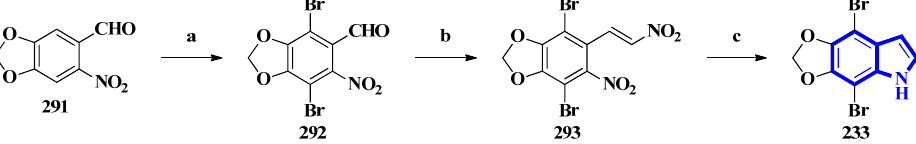
Figure 19. Amakusamine derivatives synthesized 294–308 . The first total synthesis of griseofamine B ( 314 ) and its three stereoisomers, 16-epi- griseofamine B, ent-griseofamine B, and 11-epi-griseofamine B ( 317 , 321 , and 323 ), was carried out in 2022. Compound 314 is an indole-tetramic acid alkaloid isolated from the Penicillium griseofulvum fungus in 2018 [86]. In the total synthesis, 4-bromo tryptophan methyl ester hydrochloride was used as the starting reagent, with its l-enantiomer being used to synthesize compounds 314 and 317 . d-Enantiomer 4-bromo tryptophan methyl ester hydrochloride was used to synthesize compounds 321 and 323 . All four compounds were obtained in five steps with yields of 18%, 5%, 19%, and 5%, respectively (Figure 20) [87]. Next, compound 309 was reacted with Boc 2 O, Et 3 N, and DMAP under reflux condi- tions in DCM to afford 310 in 90% yield. A Heck–Mizoroki reaction of 310 with 2-methyl- 3-buten-2-ol in the presence of PdCl 2 (PPh 3 ) 4 , Ag 2 CO 3 , and Et 3 N in 1,4-dioxane produced compound 311 in 67% yield. Afterward, refluxing 311 with PdCl 2 (CH 3 CN) 2 in CH 3 CN generated a pair of diastereomers 312 and 315 . TMSOTf and 2,6-lutidine in DCM were used to remove the Boc groups and gave compounds 313 and 316 . A tandem acyla- tion/Lacey–Dieckmann cyclization of 313 and 316 with diketene was performed to afford 314 and 317 , respectively. Additionally, using the same synthetic scheme with compound 318 as the starting reagent afforded compounds 321 and 323 [87].